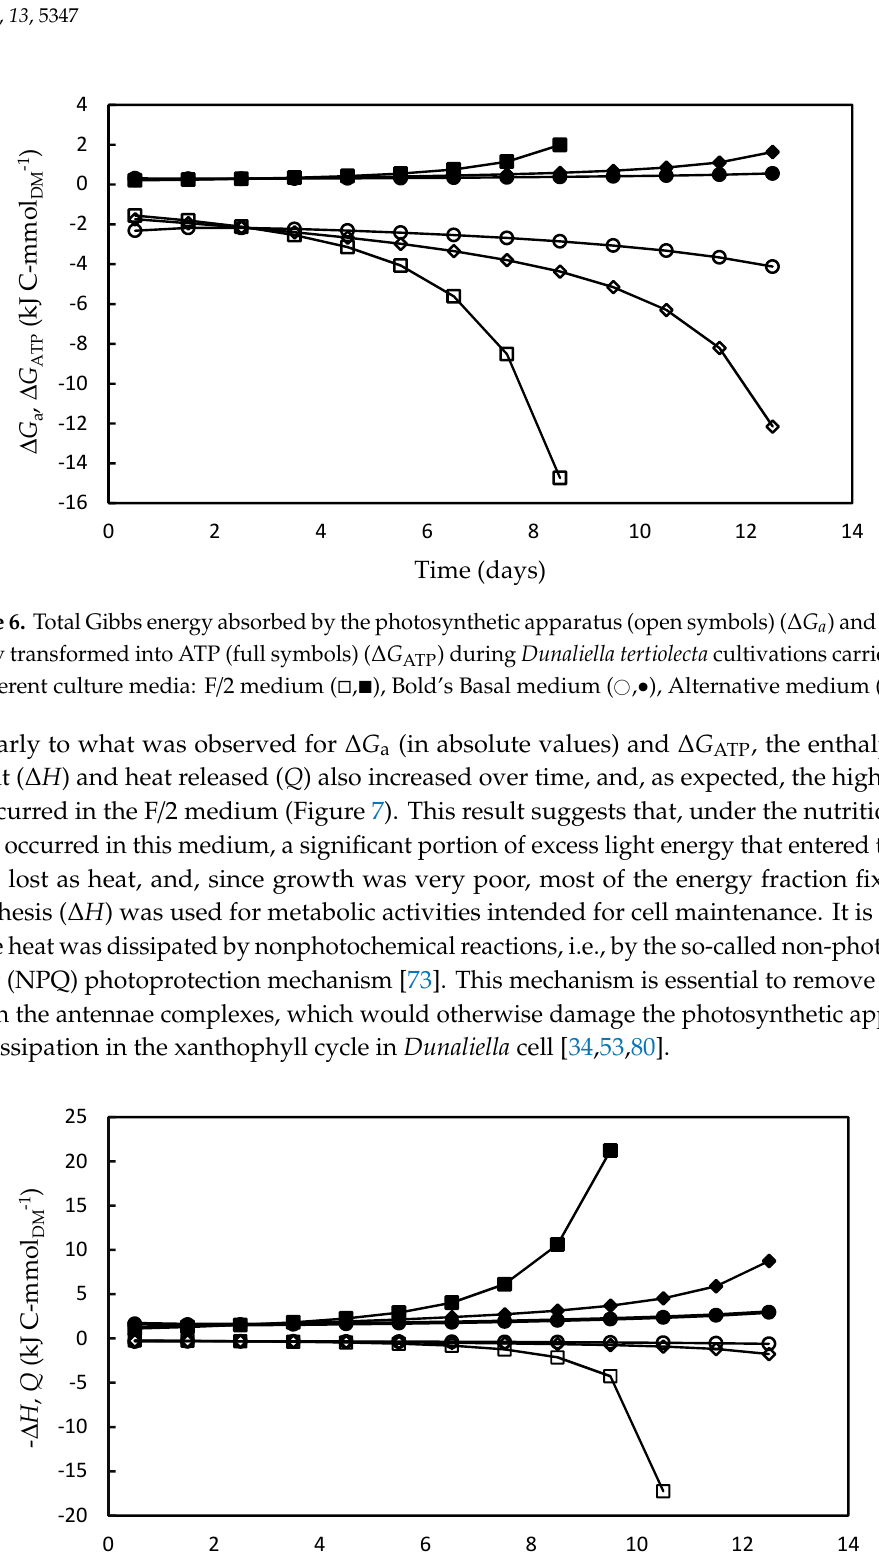
Figure 7. Energy fixed by the photosynthetic apparatus (open symbols) ( ∆ H ) and energy released as heat (full symbols) ( Q ) during Dunaliella tertiolecta cultivations carried out in di ff erent culture media: F / 2 medium ( (cid:3) , (cid:4) ), Bold’s Basal medium ( , • ), Alternative medium ( , (cid:117) ). The choice of illustrating - Q instead of Q was only due to the need to avoid overlapping with the ∆ H curves.